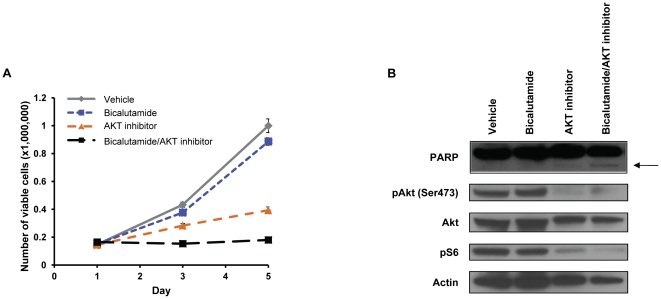
Akt1/2 inhibitor cooperated with bicalutamide to induce LNCaP cell apoptosis.(A) Number of viable LNCaP cells treated over 5 days with vehicle, bicalutamide (1 uM), Akt1/2 inhibitor (1 uM), or a combination of bicalutamide and AKT inhibitor. (B) Apoptosis was measured in LNCaP cells by immunoblotting using a PARP antibody in LNCaP cells treated as in (A). Inhibition of phosphorylated Akt (pAkt (Ser473)) and phosphorylated S6 (pS6) was also measured. Actin was used as a loading control.